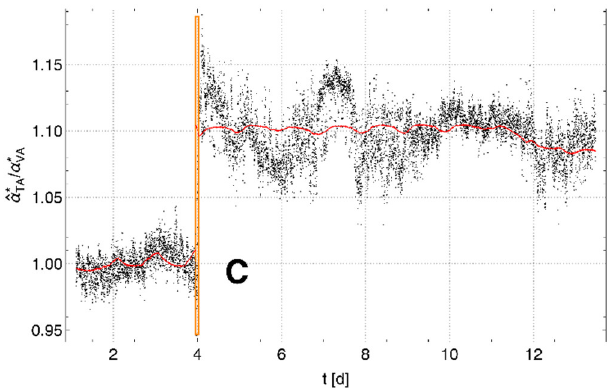
Figure A3. Ratio ˆ α ∗ / α ∗ (black) of the adjusted set of cells for both phases of the experiment. The TA VA orange box marked C indicates the change from Phase 1 to Phase 2. The solid lines (red) represent the ratio based on the calculated data.